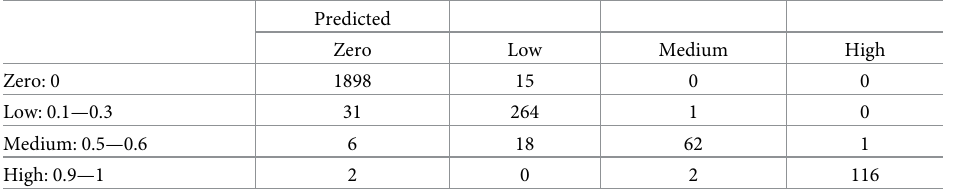
Table 4. Multinomial logistic regression binned with respect to fibrotic pathology grades: Zero (0), low (0.1–0.3), medium (0.5–0.6), high (0.9–1). Predicted Zero Low Medium High